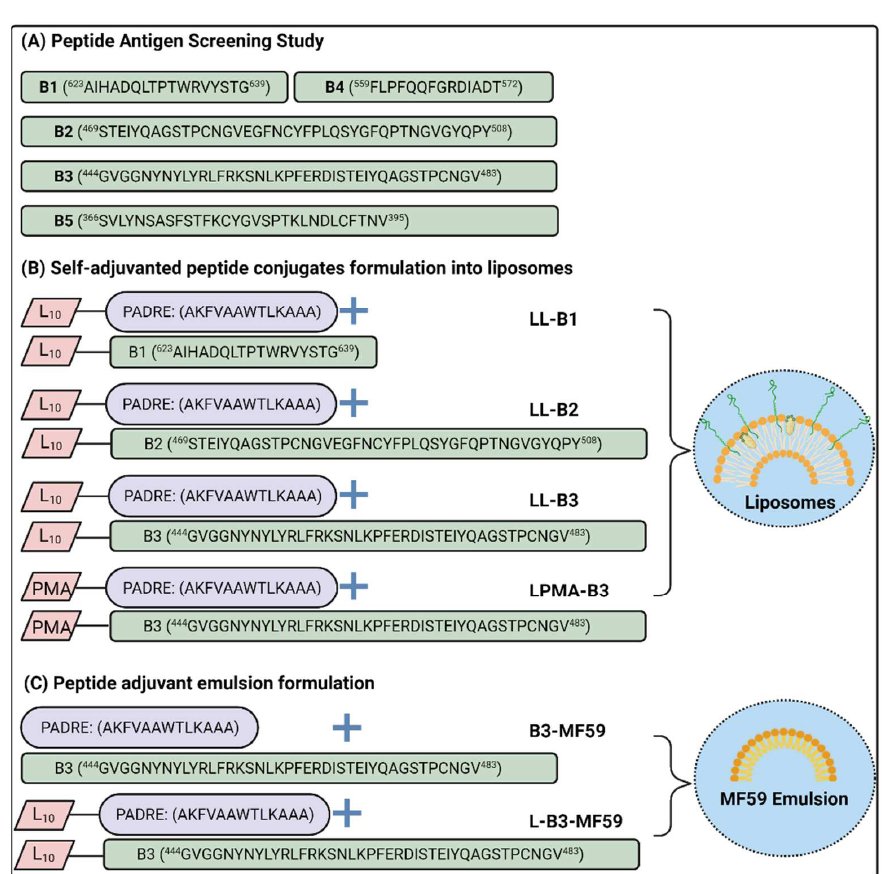
Figure 1. SARS-2 peptide antigens and their vaccine formulations. Amino acid single code letters were used to describe the synthesized sequences. ( A ) Peptide antigens B1–B5 and their location in the spike protein sequence; ( B ) self-adjuvanted peptide–polymer conjugates formulated into liposomes; and ( C ) peptide antigen, B3, and its polyleucine conjugate emulsified with MF59. L refers to 10-mer polyleucine; LL refers to liposome coated with polyleucine-conjugated peptide for anchoring; LPMA refers to liposome coated with PMA-conjugated peptide antigen; MF59 is an emulsion adjuvant formulation; PADRE is universal helper T-cell epitope; and PMA is polymethyl acrylate polymer. Crude compounds were analyzed using analytical Shimadzu HPLC (Shimadzu